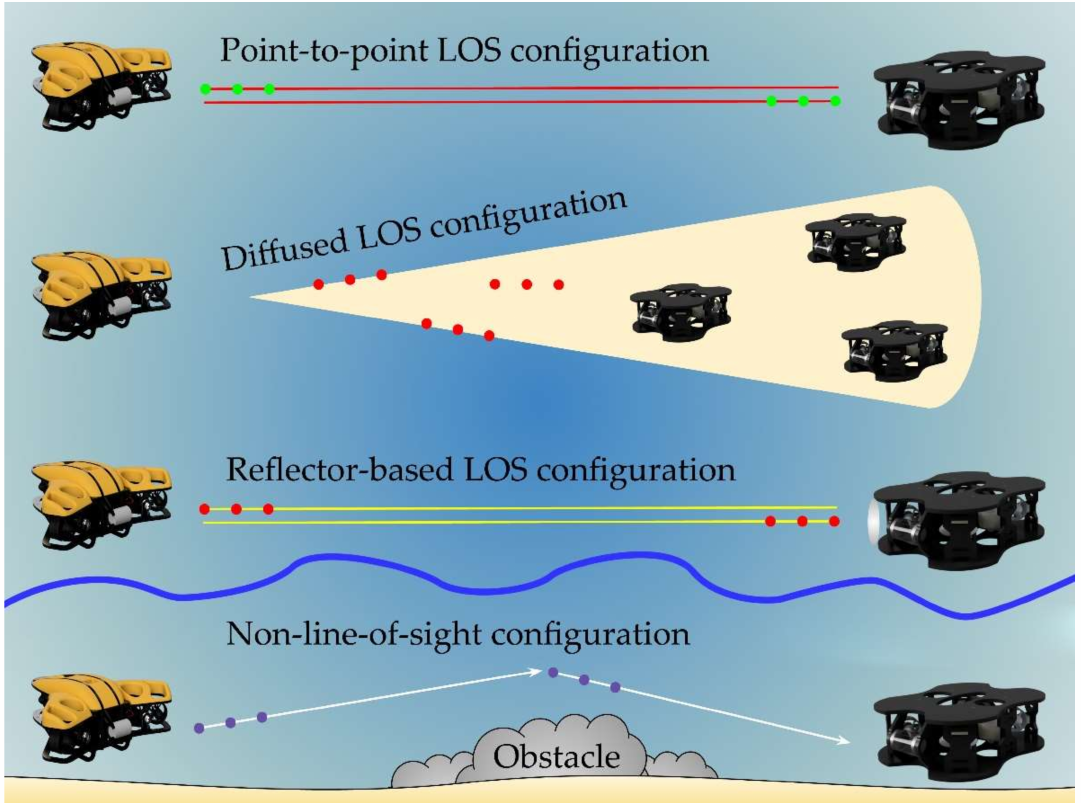
Figure 3. UWOC usage